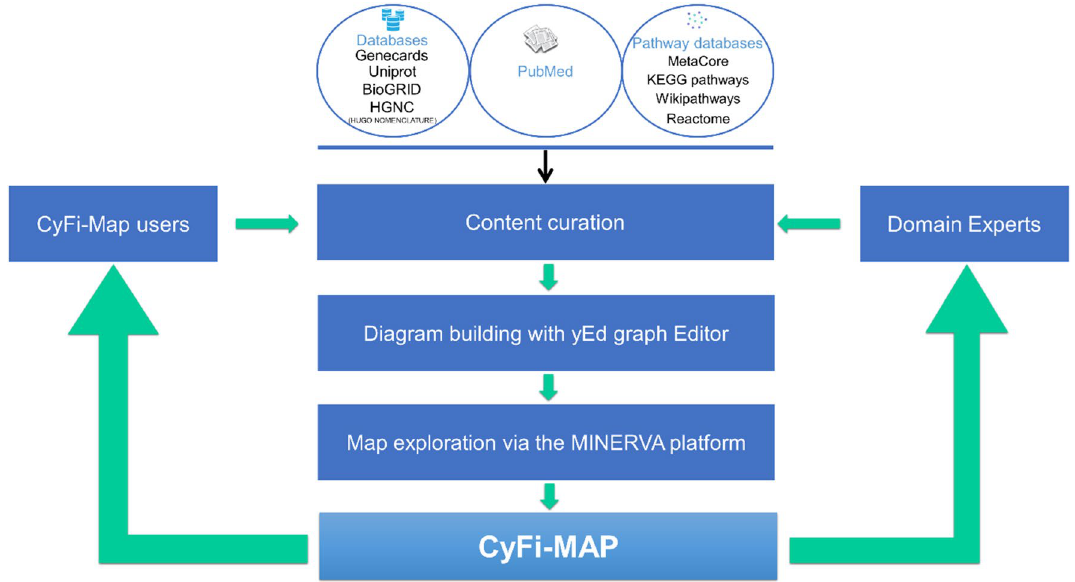
Figure 8. Workflow of CyFi-MAP construction. Starting by the research and curation of data contained in general and CFTR-specific databases and peer-reviewed research papers, CyFi-MAP was constructed based on domain experts’ suggestions and users’ comments. The organization of the curated data required the selection of a general format to be used throughout the platform, which determined the map assembly and content visualization. After the map was built, domain experts were once again consulted, in order to review and provide feedback on the accuracy of the representation of the disease mechanisms, as well as the usability of the